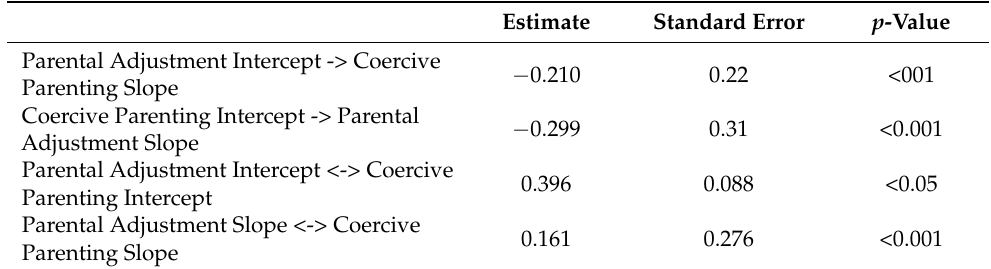
Table 3. Estimate, Standard error of Coefficient and p -values of slopes and intercepts